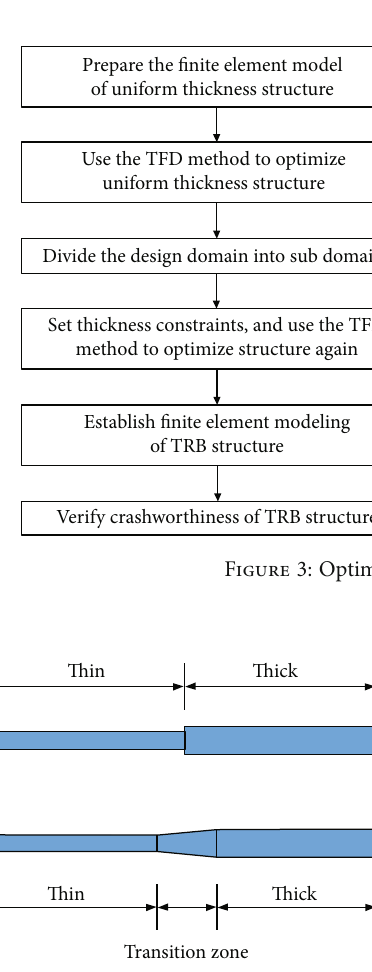
Figure 4: Thickness distribution of TRBs.